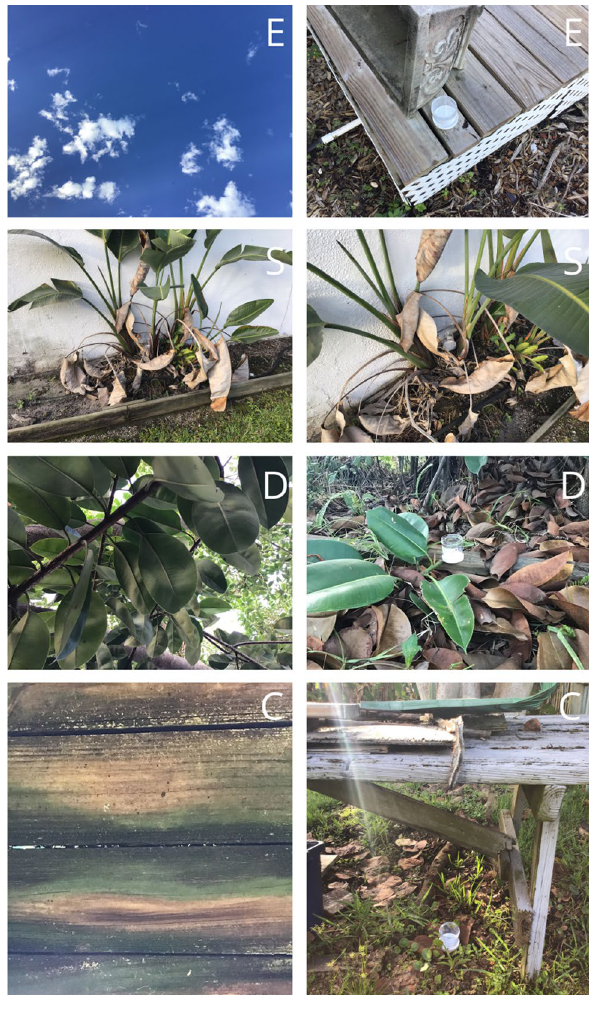
Fig. 4 Sampling location coverage type in the treatment site. From top to bottom: (E) Exposed to sky, (S) sparse vegetation cover, (D) dense vegetation cover, and (C) covered (obstructed from